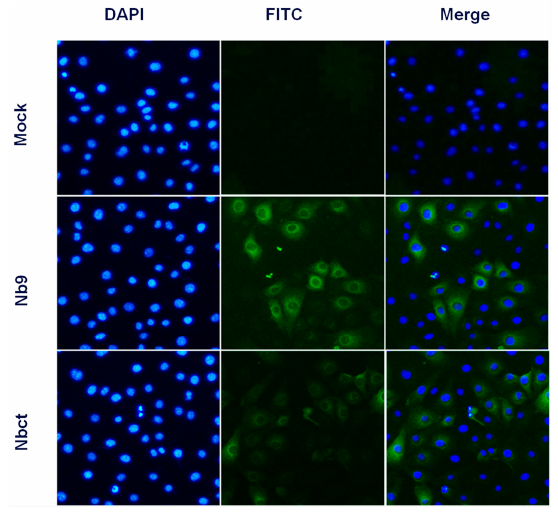
Figure 5. Internalization of Nb9 and Nbct in Marc-145 cells. Cells were incubated sequentially with 80 μ M of each Nb, mouse anti-His6 mAb, and FITC-conjugated goat anti-mouse IgG. Signals of Nb9 or Nbct (green) and cell nuclei (blue) were visualized by inverted fluorescence microscope (magnification, 400×).